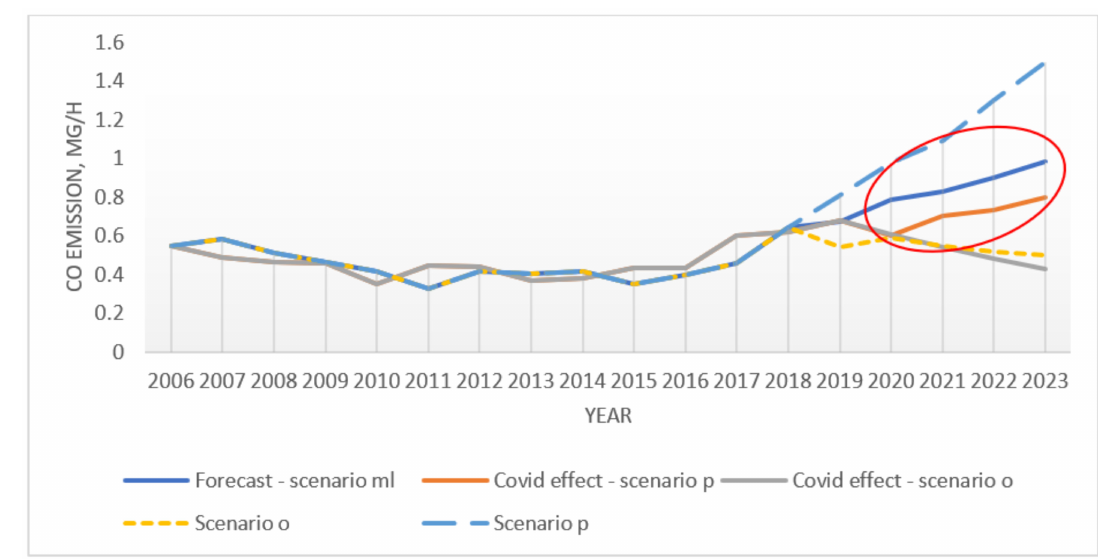
Figure 18. Results of the simulation of the average CO emission level in particular years until 2023. Source: Own elaboration, based on data from Copernicus Atmosphere Monitoring Service (CAMS) [47].